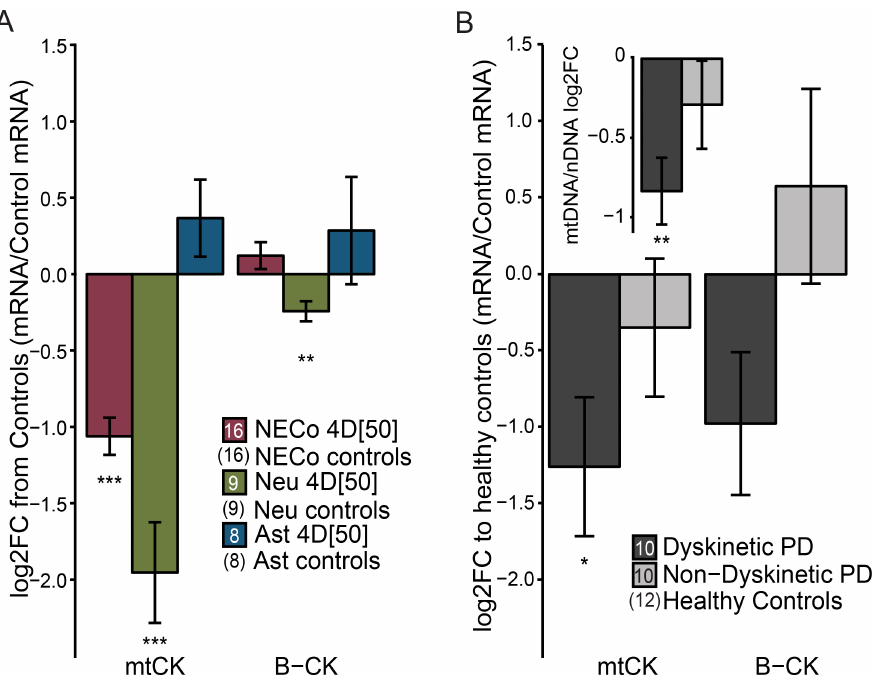
Fig 8. DecreasedmtDNA quantity corresponds to decreasedexpression of mtCK. (A) Log2-foldchange of mtCK and B-CK expressionin rat NECos, neurons, and astrocytes, normalized to reference genes. (B) Log2-foldchangeof mtCK and B-CK expression in matched human dyskinetic and non-dyskinetic PD patients, normalized to reference genesand relative to control subjects. Inset: RelativemtDNA quantity from the same cohort as in (B), normalizedto nDNA [43]. (A) *** = p < 0.001; ** = p < 0.01, relative to respective controls. (B, inset). ** = p < 0.01, * = p < 0.05, followingTukey’s HSD post-hoc test.